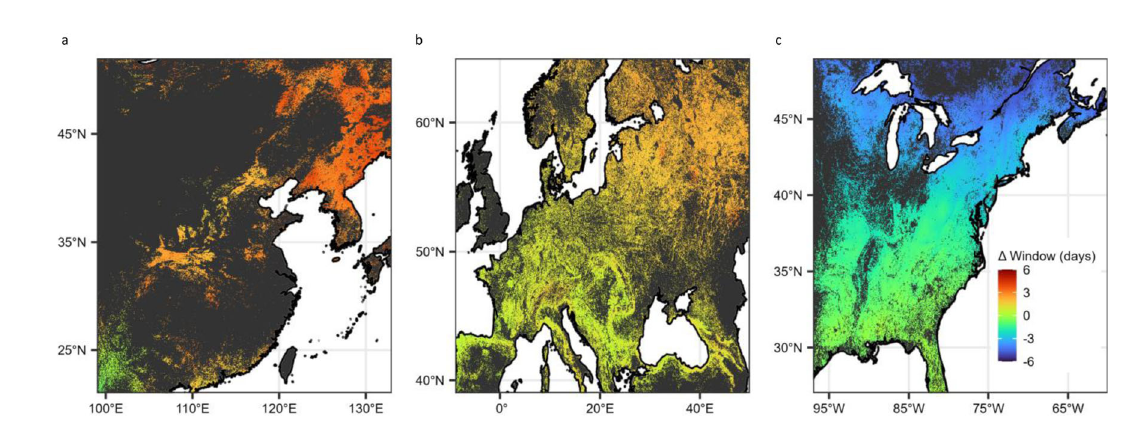
Fig. 4 | Projected changes in phenological escape between current climate conditions and those projected for theend ofthis century. Projected changein spring light window duration ( Δ Window, days) in a Asia, b Europe, and c North America. Positive values indicate regions where light window duration is expected to increase with spring warming (particularlyin northernAsia)and negative values